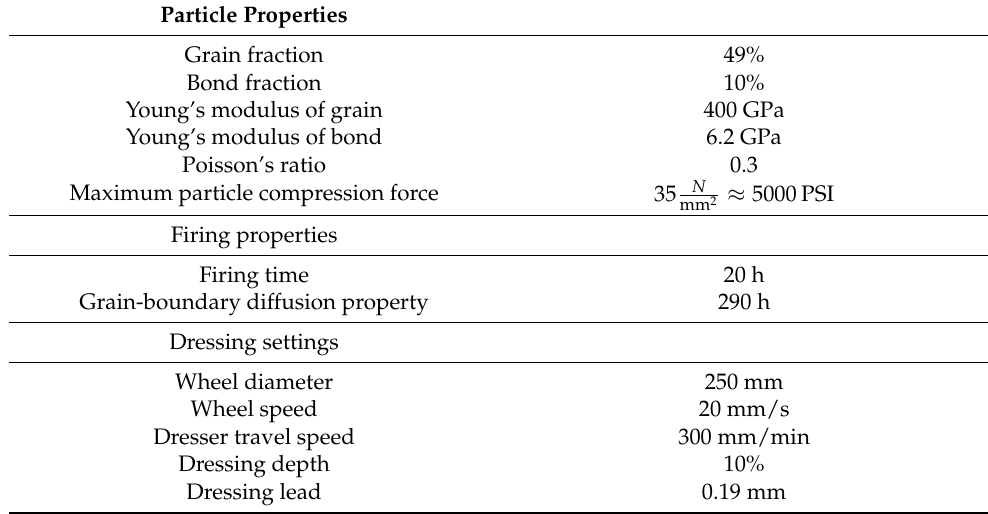
Table 1. Simulation properties and